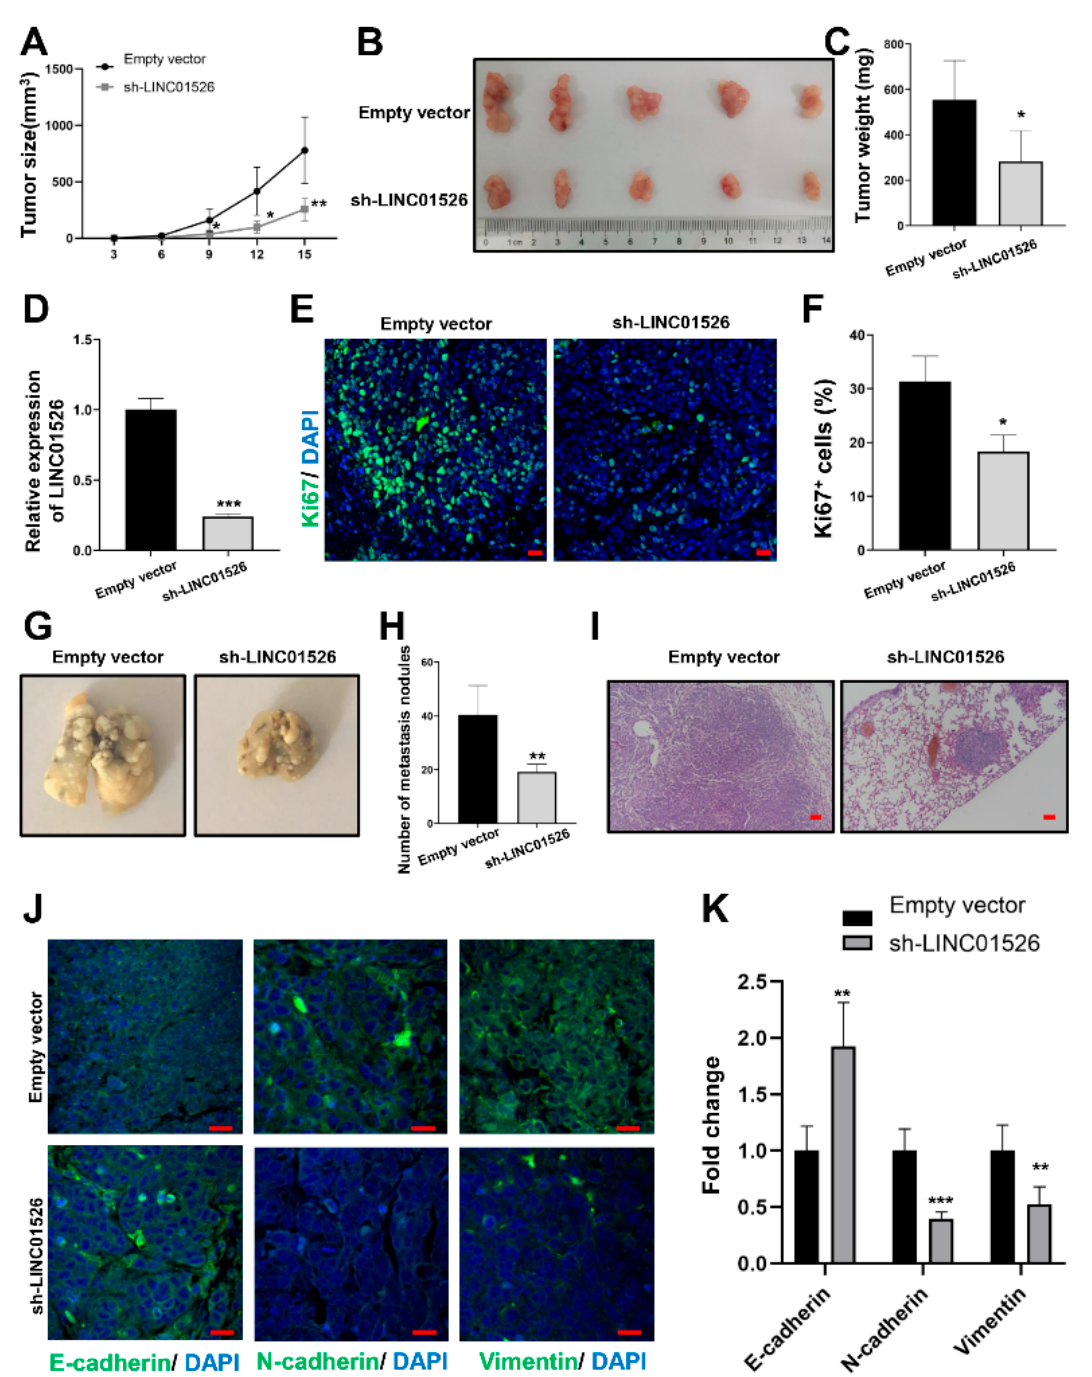
Figure 3. The effect of LINC01526 on GC cell proliferation and migration in vivo. ( A ) tumor volume, ( B ) macroscopic appearance, and ( C ) weight of tumors resulting from the subcutaneous injection of HGC-27 cells transfected with sh-LINC01526 or an empty vector into nude mice (n = 5). ( D ) Relative LINC01526 expression levels in tumors in the sh-LINC01526 and empty vector group, assessed by RT-PCR. ( E ) Ki-67 levels measured by immunofluorescence; scale bars: 20 μ m. ( F ) Quantification of results from ( E ). ( G ) Lung tissues removed from nude mice 2 months after the injection of HGC-27 cells transfected with sh-LINC01526 or an empty vector into the tail vein (n = 5). ( H ) Lung nodule counts. ( I ) H&E staining of mouse lung tissues; scale bars: 100 μ m. ( J ) Immunofluorescence staining of E-cadherin, N-cadherin, and vimentin; scale bars: 20 μ m. ( K ) Quantification of ( J ). * p < 0.05, ** p < 0.01, and *** p < 0.001.